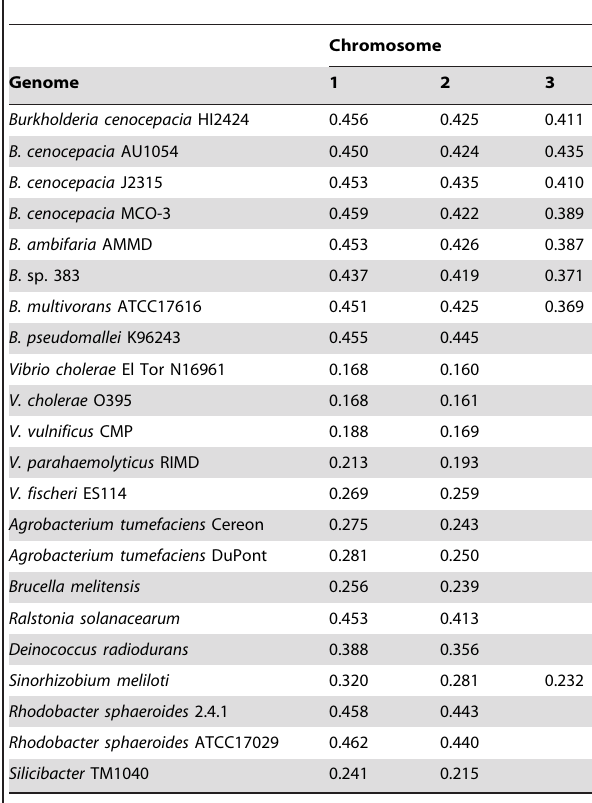
Table 1. Codon preference (SCUO [27]) is weaker on secondary chromosomes found in all bacterial genomes with multiple